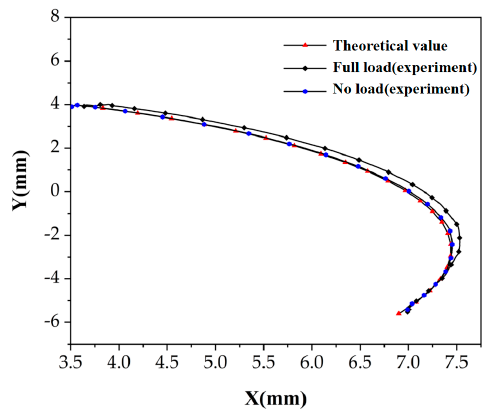
Figure 11. Trajectory comparison.